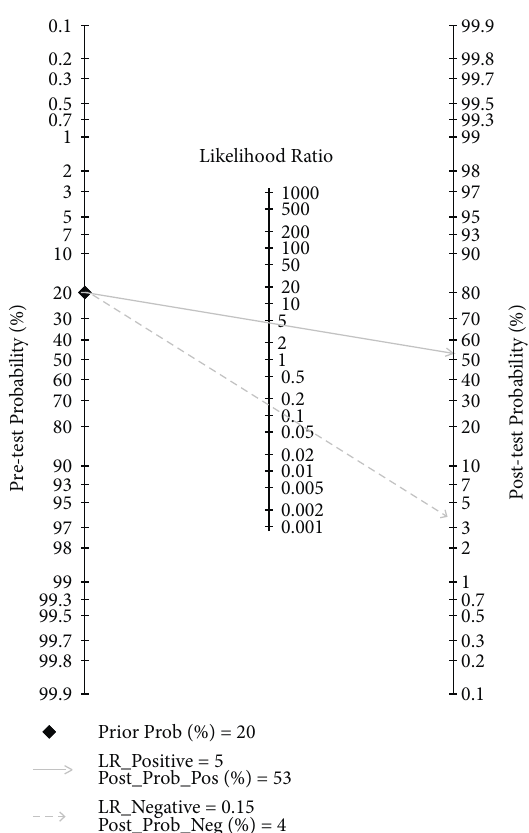
Figure 8: Evaluation of clinical applicability of AI-assisted diagnostic techniques in TN diagnosis: Fagan nomogram.